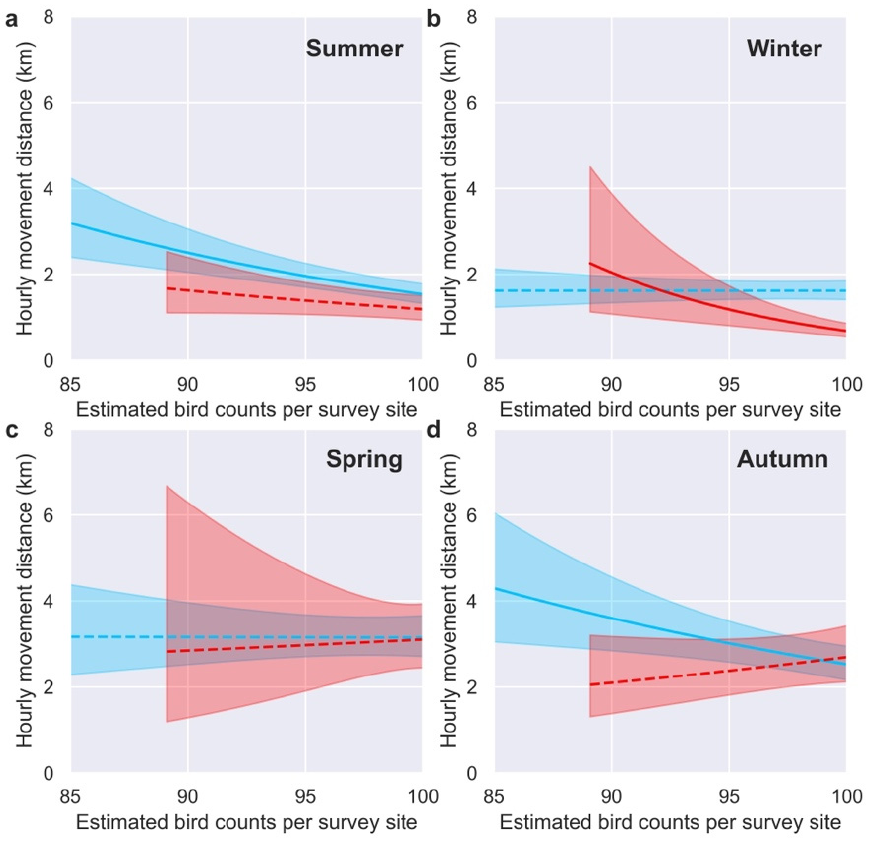
Figure 2. Effects of seasons and relative population abundance on average hourly movement dis- tances of American White Pelicans. Panels show ( a ) summer, ( b ) winter, ( c ) spring migration, and ( d ) autumn migration. Blue and red colors represent wintering groups at Northern and Southern Gulf of Mexico, respectively. Polygons represent 95% confidence intervals of the average hourly movement distances.